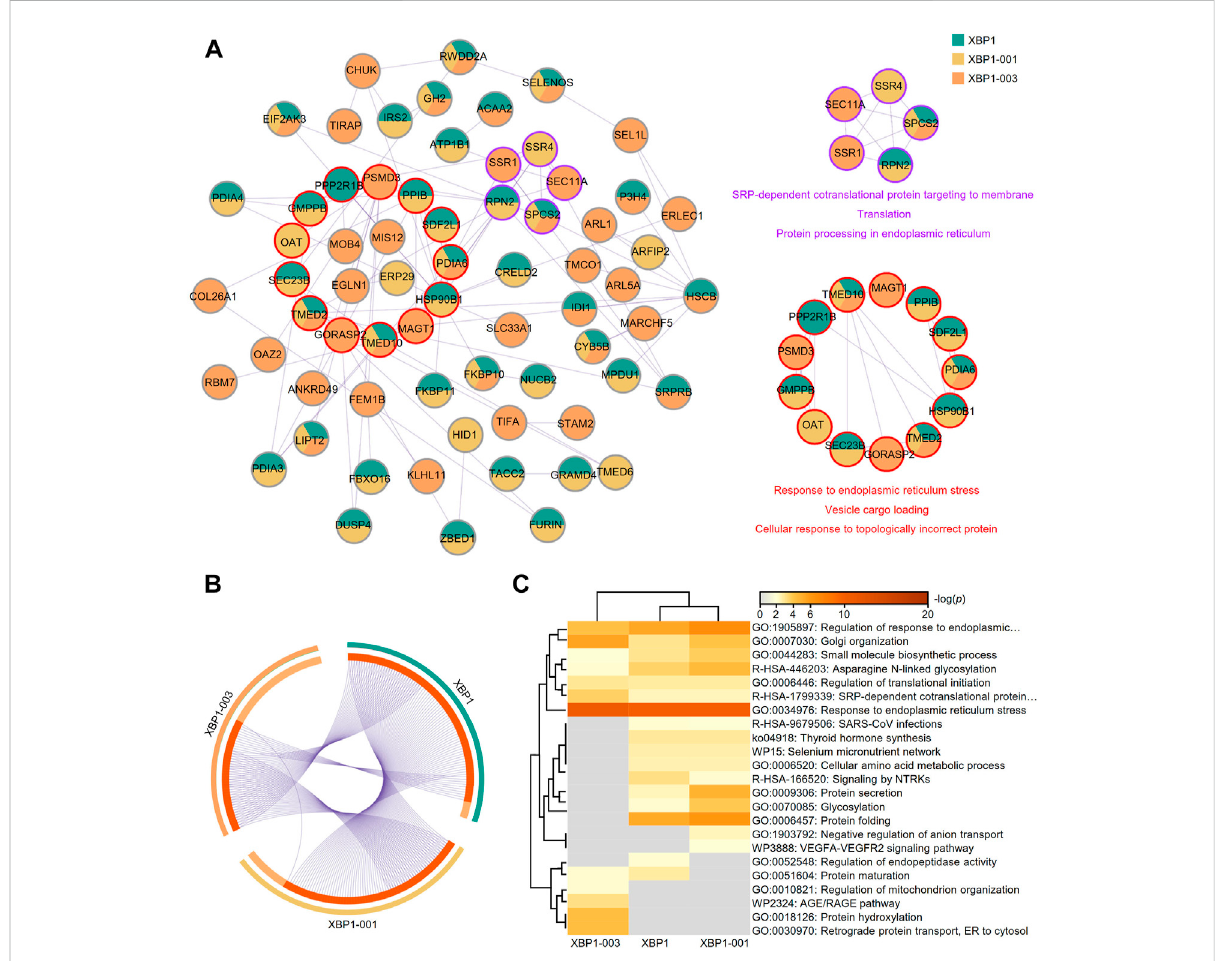
FIGURE 7 Metascapeanalysisofthetop100geneswithsimilarexpressionpro fi lesofXBP1isoformsinLUAD. (A) ThePPInetworkandtwomodules(purpleand red) with signi fi cance were obtained by Metascapeanalysis. (B) Overlap of the top100 genes with similar expression pro fi les of totalXBP1, XBP1-001and XBP1-003inLUAD. (C) Heatmapofthetop100geneswithsimilarexpressionpro fi lesoftotalXBP1,XBP1-001andXBP1-003inLUAD,coloredby p